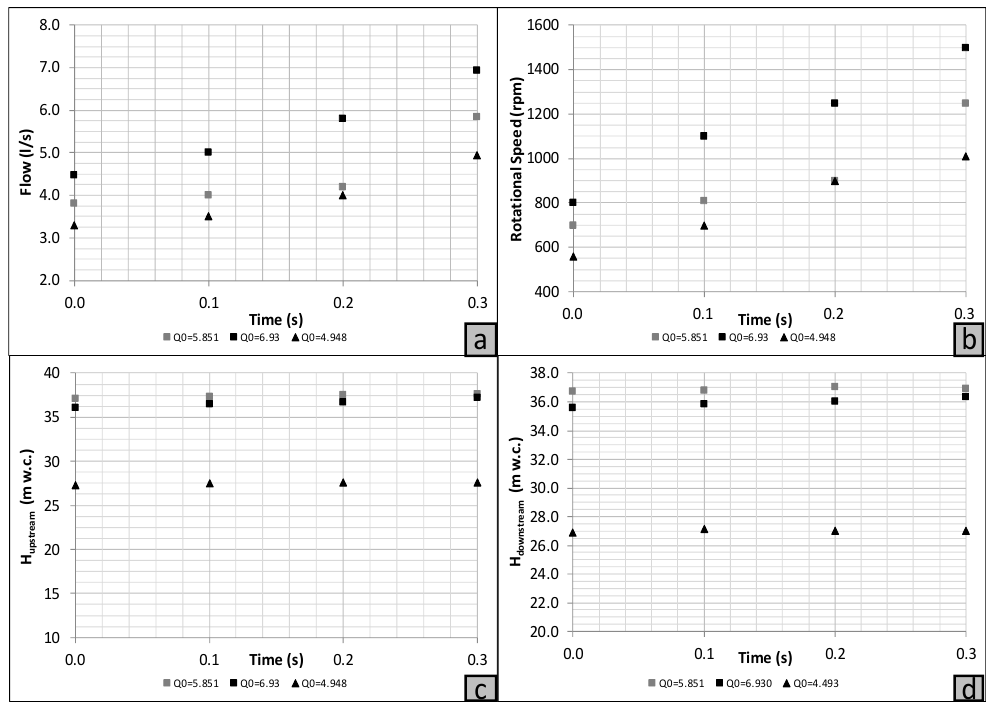
Figure 15. Experimental data of ( a ) flow, ( b ) rotational speed, and ( c ) the upstream and ( d ) downstream head in the axial machine under the overspeed effect.